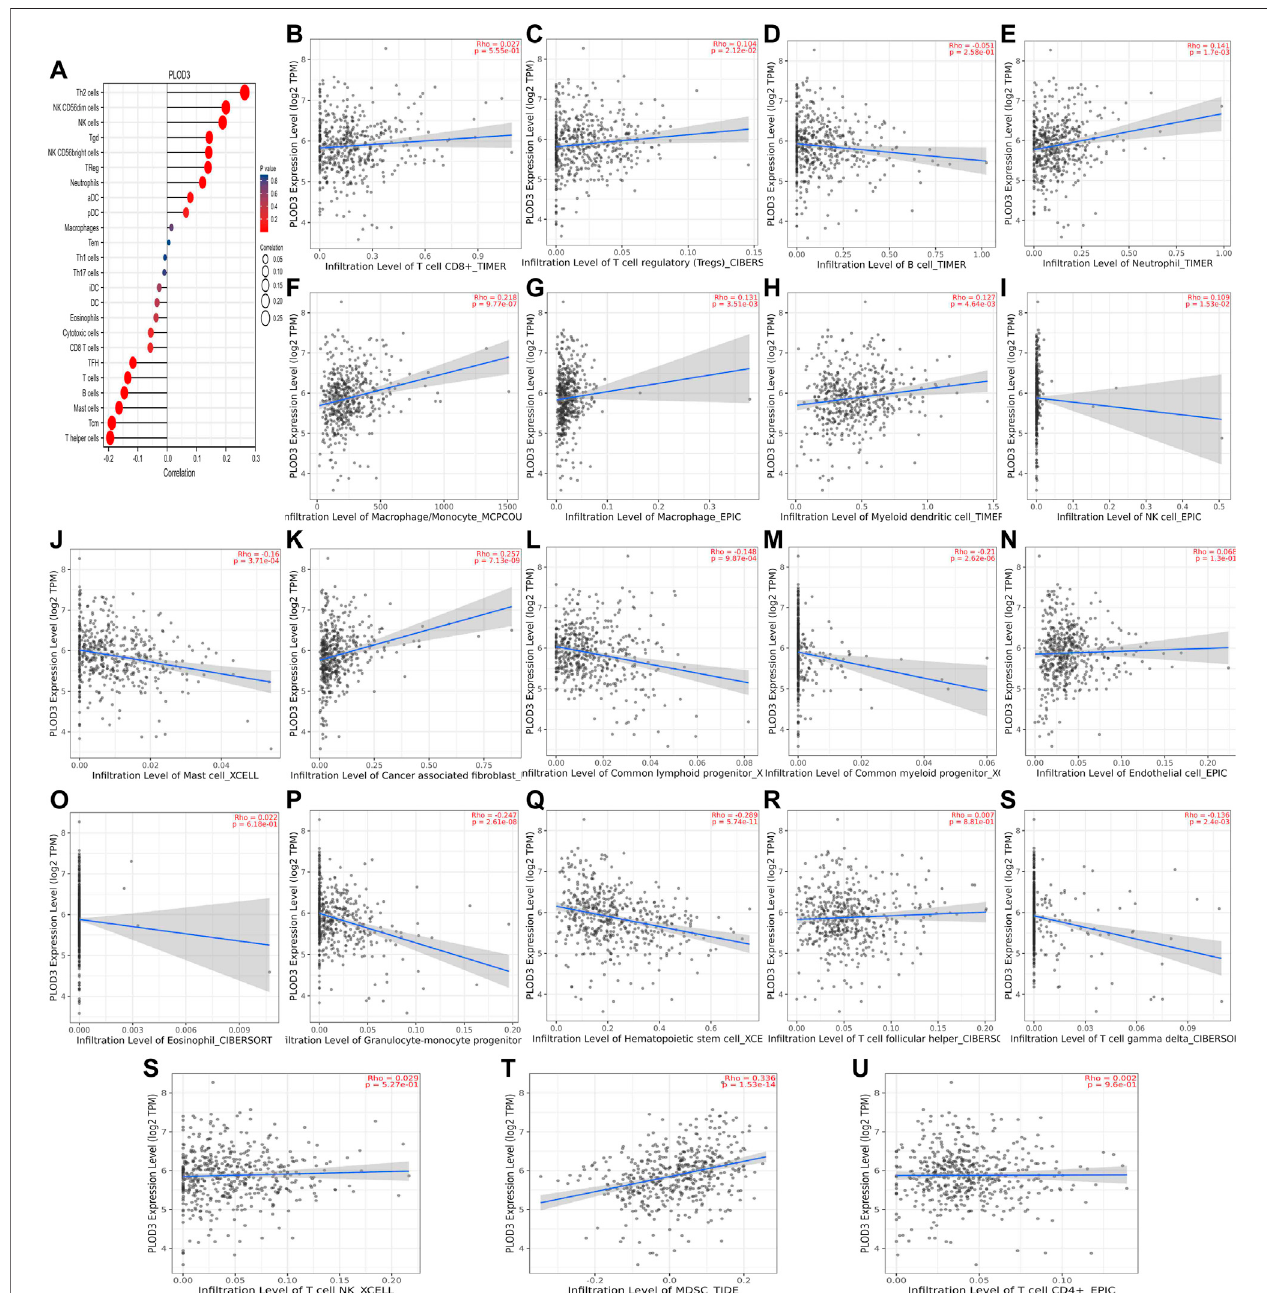
FIGURE11| Associationbetween PLOD3 andimmunein fi ltration. (A) Summaryplotoftherelationshipbetween PLOD2 expressionand immunein fi ltration. (B – U) PLOD3 expression is negatively related to tumor purity and has correlations with TFH, CD8 + T, TH, dendritic, cytotoxic, and mast and B cells; on the contrary, it is positively correlated with Tregs, macrophages, and cancer-associated fi broblast cells.